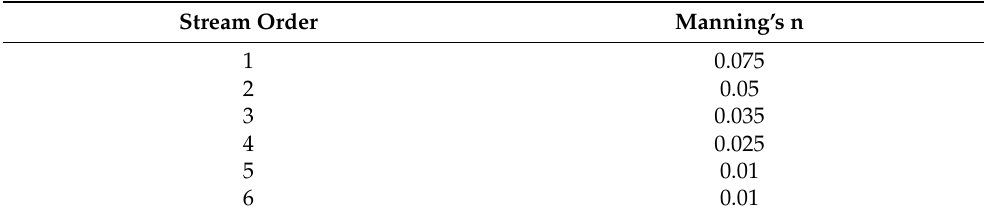
Table 3. Manning roughness coefficients by Strahler stream